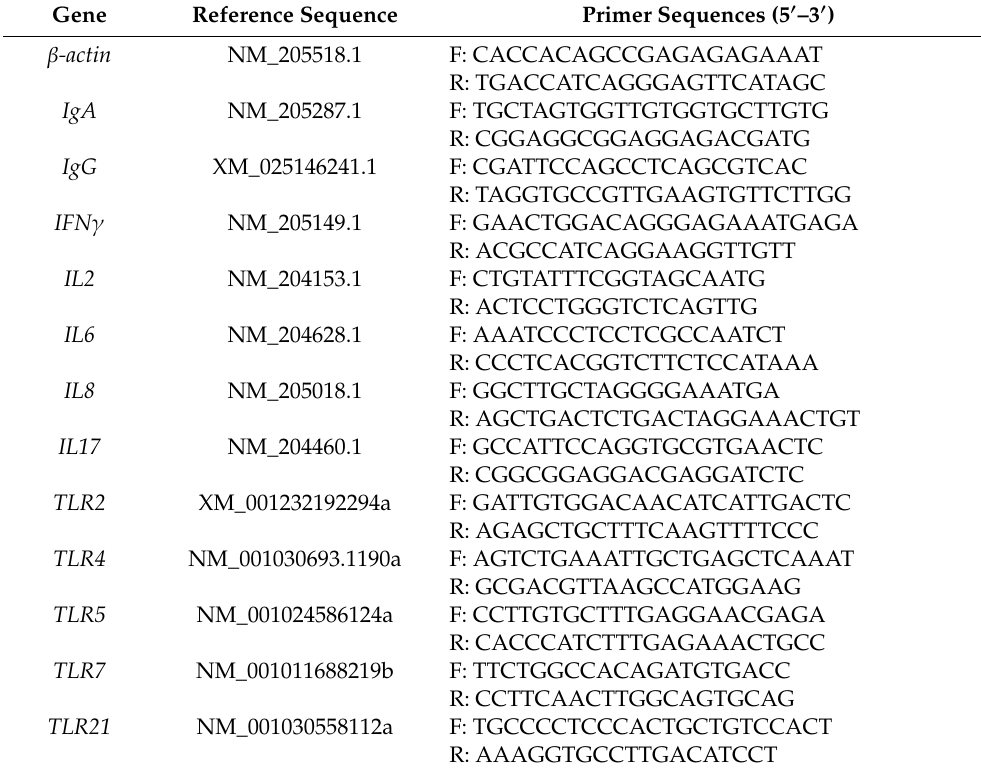
Table 1. Primer sequences used in the real-time quantitative reverse transcription